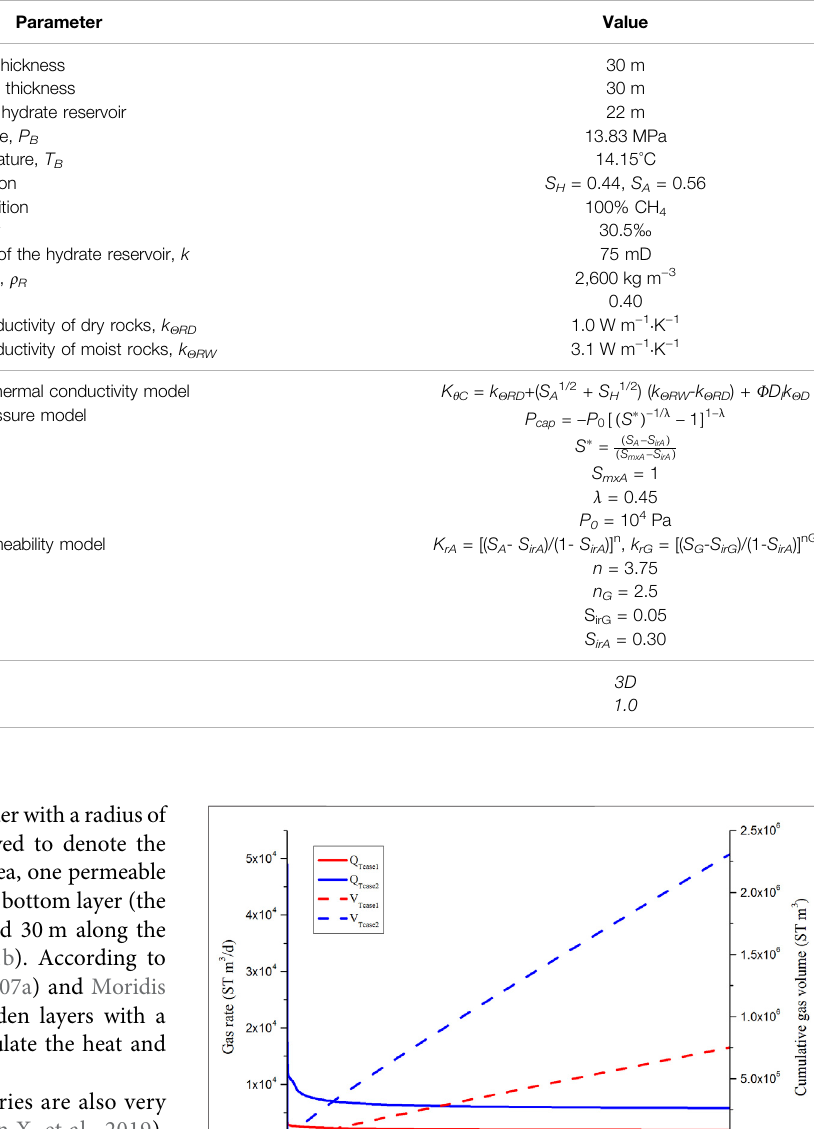
TABLE 1 | Main properties and parameters used in the hydrate reservoir model.